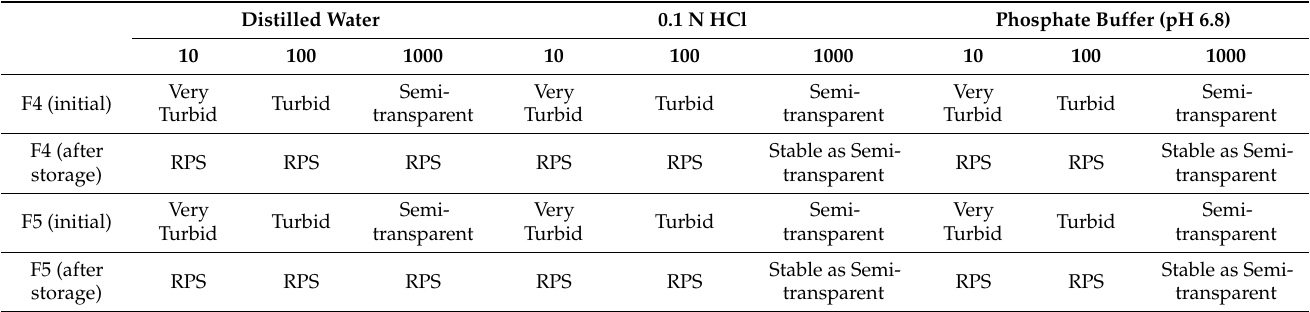
Table 3. Robustness to dilution of the drug-loaded formulations.